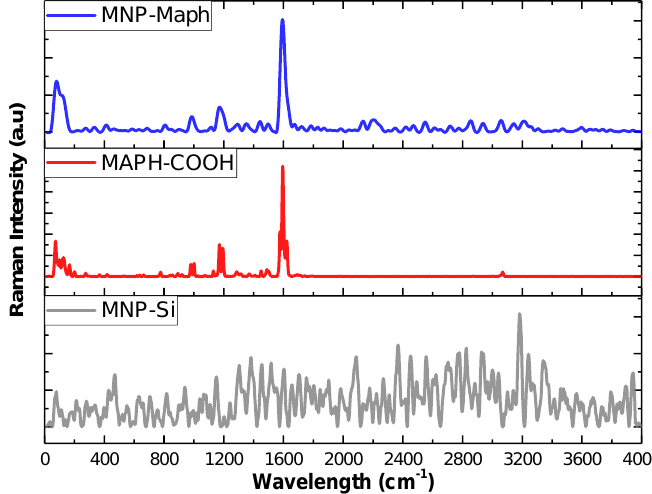
Figure 1. Raman spectra of functionalized magnetic nanoparticles.